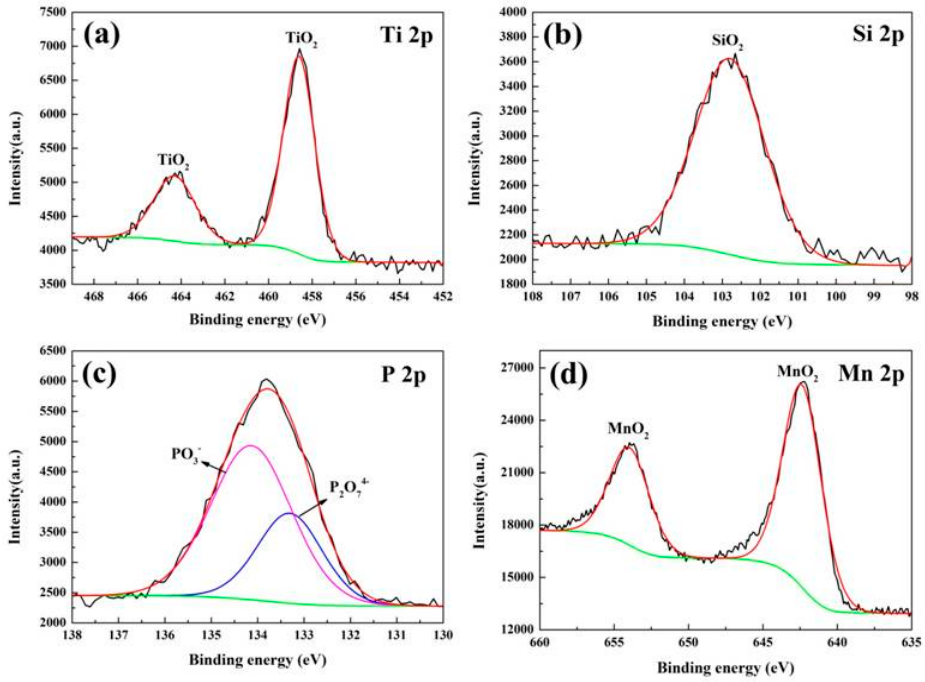
Figure 7. XPS spectra of MAO coatings prepared at KMnO 4 concentration of 3.2 g/L: ( a ) Ti2p; ( b ) Si2p; ( c ) P2p; ( d ) Mn2p.